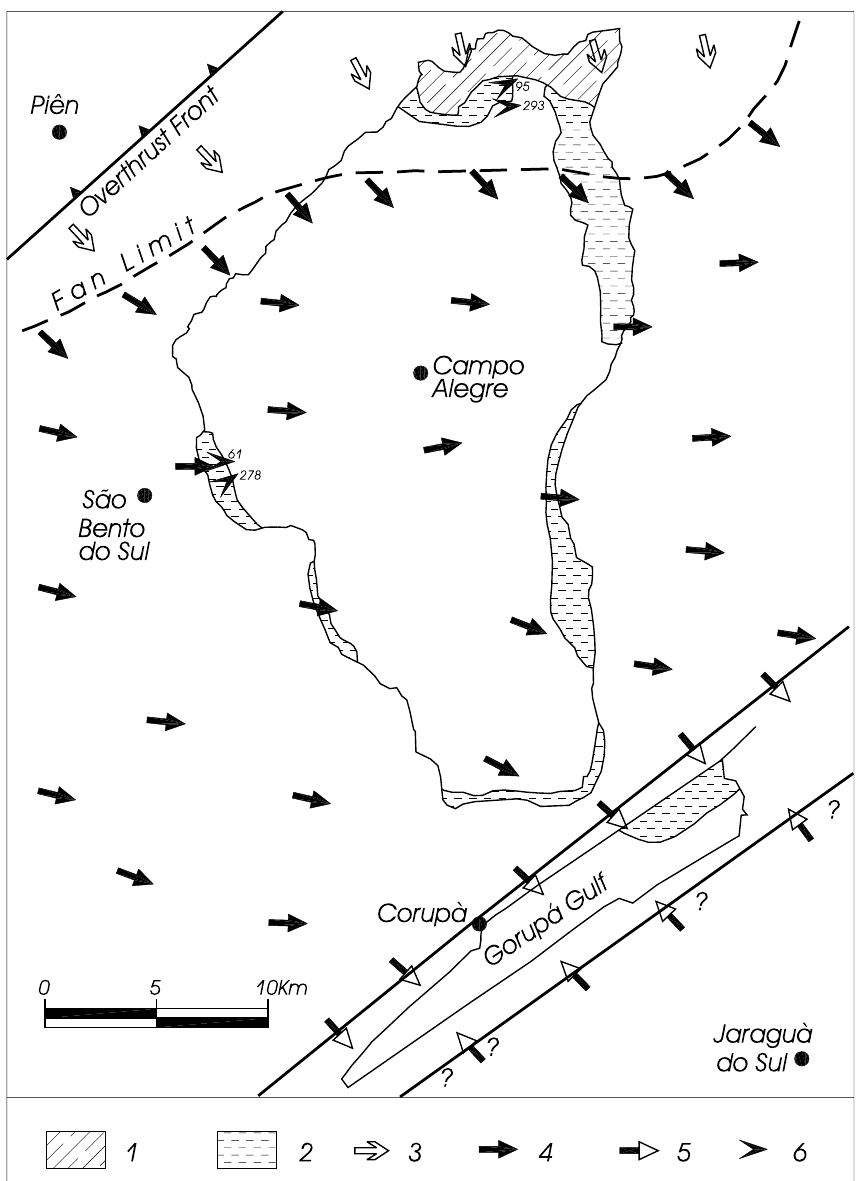
Fig. 3 – Location of the units deposited during the first stage of the Campo Alegre Basin with the paleogeographic situation. 1)- Papanduvinha Mb.; 2)- São Bento do Sul Mb.; 3)- alluvial fans; 4)- braided rivers; 5)- fan deltas; 6)